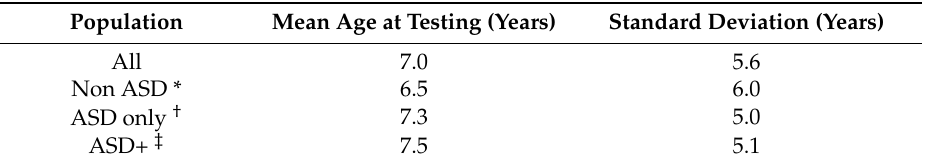
Table 2. Mean age at chromosomal microarray analysis (CMA) testing, grouped by diagnostic referral codes. Population Mean Age at Testing (Years) Standard Deviation (Years) All